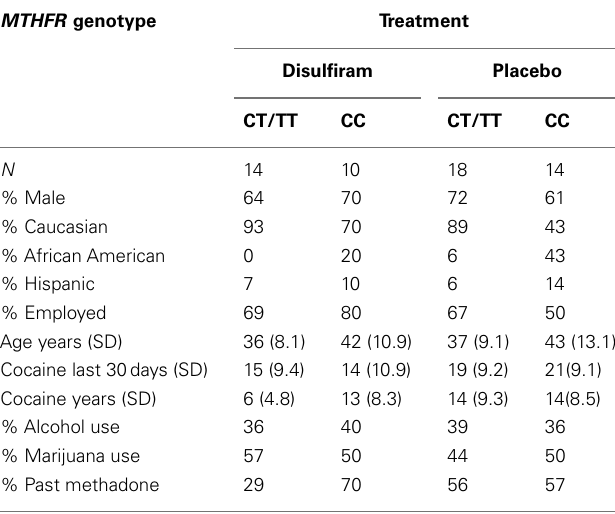
Table 1 | Clinical and demographic characterization by treatment